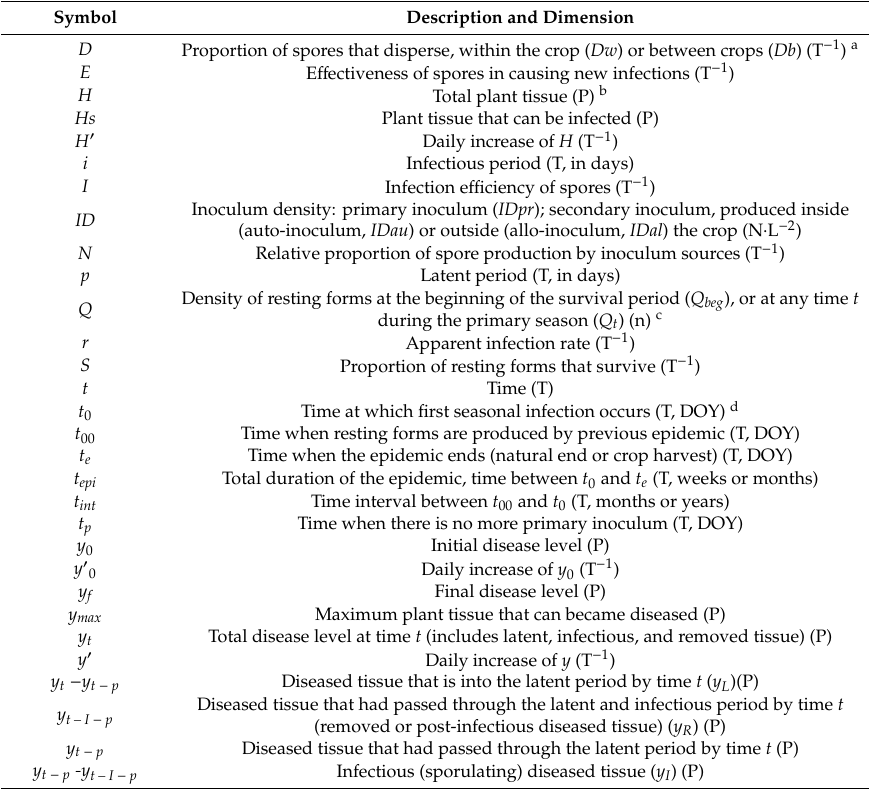
Table 1. List of symbols used in the